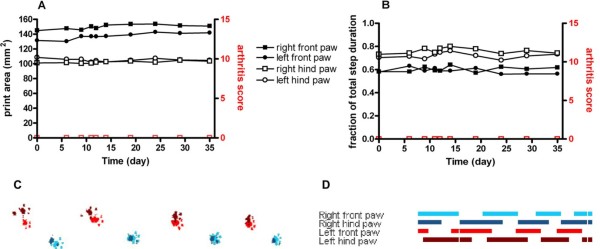
Gait analysis by CatWalk in a healthy rat. Time course of the print area (A) and the duration of stance phase measured as the fraction of total step duration (B) of all four paws in a 10-week-old female control rat walking across the CatWalk walkway. Front paws are shown with filled symbols, hind paws with open symbols. Extremities of the right side are indicated as squares, of the left side as circles. Gait variables are depicted in black, arthritis scores in red. (C) Picture of CatWalk footprints on Day 24 after injection of PBS. Prints of the left paws of the rat are shown in red, and prints of the right paws are shown in blue. Prints of front paws are depicted in lighter colour, whereas prints of the hind paws are darker. (D) Picture of the CatWalk gait diagram 24 days after PBS-injection. Indicated are the paw-floor contacts for each of the paws over time. The length of each bar represents the duration of the stance phase for that particular paw. The space between bars represents the duration of the swing phase. No conspicuous changes in gait variables were detected.